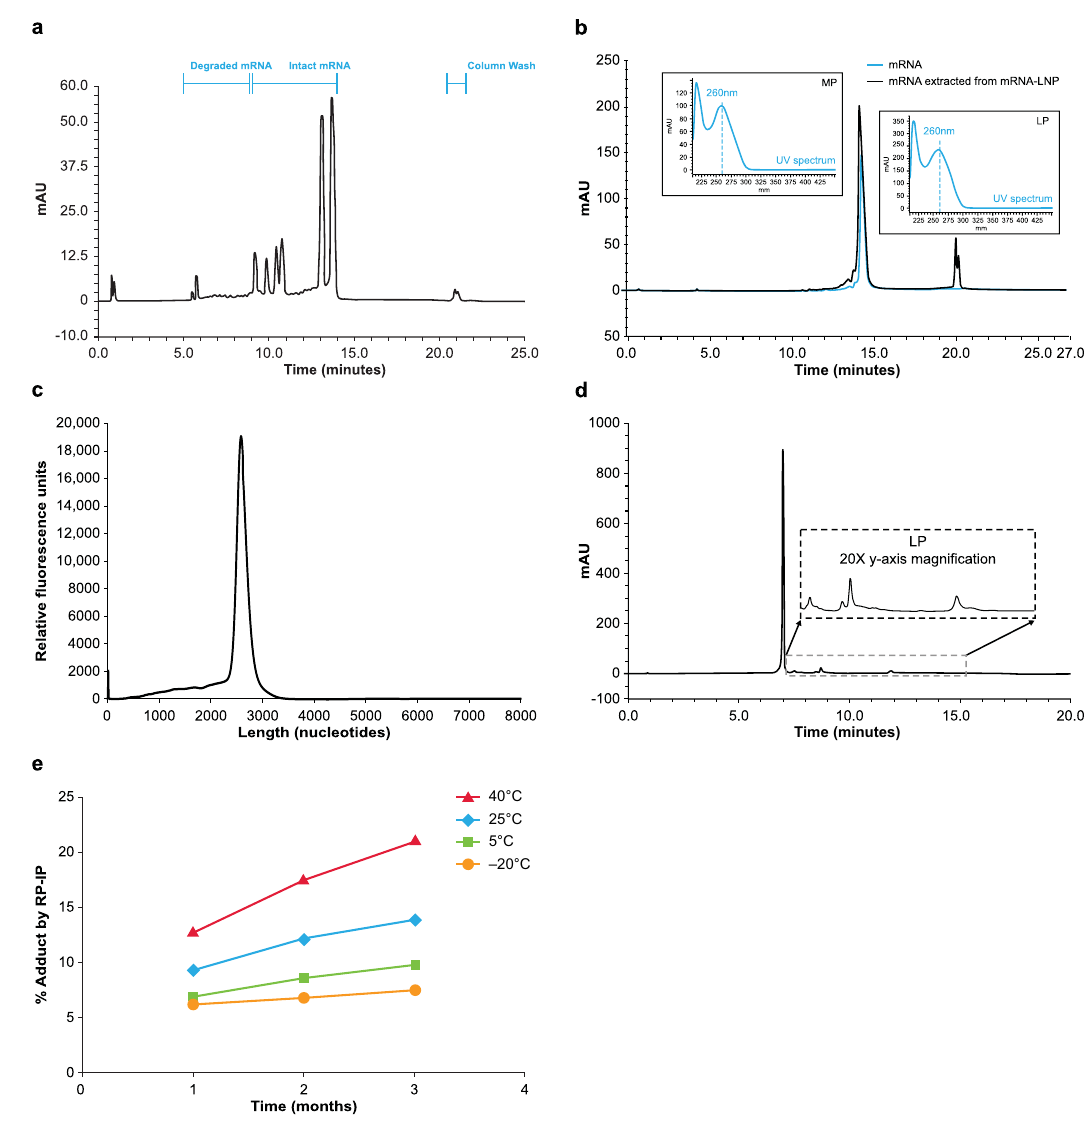
Fig. 1 Identi fi cation of LP in formulated mRNA-LNP by RP-IP HPLC. a Reversed phase-ion pair high performance liquid chromatography (RP-IP HPLC) provides high resolution mRNA length-based separations to assess content and quality of mRNA products, as shown by the separation of 6 mRNAs of different lengths (659, 785, 914, 1106, 2498, and 2993 nucleotides) in a single lipid nanoparticle (LNP) formulation across retention times of 9.5 – 15 min. Peaks prior to 9.5 min are degradants and the peaks at 22 min form part of the column wash. b The RP-IP HPLC analysis of pure mRNA (blue) yields a single MP (retention time 15 min), with shorter degradation products and impurities eluting prior (retention time, 10 – 14.5 min), whereas mRNA extracted from an mRNA-LNP formulation (black) yields an additional late-eluting peak region (LP; retention time 19 – 21 min). The UV spectrum at each peak apex obtained from an on-line 3D UV detector shows an identical pro fi le with maximum absorbance of 260 nm (inset). c CE analysis of extracted mRNA shows a single peak, with no additional late-eluting species. d LP species in mRNA extracted from an mRNA-LNP formulation can be further resolved with adjusted gradient conditions and show a polydisperse fi ngerprint of species. e An mRNA-LNP formulation was stored for 3 months at 4 different temperatures (40 °C, red; 25 °C, blue; 5 °C, green; − 20 °C, orange), and sampled at 1, 2, and 3 months for analysis by RP-IP HPLC; each data point is a single incubation condition run in a single RP-IP HPLC assay. Representative data are shown. AU, absorption